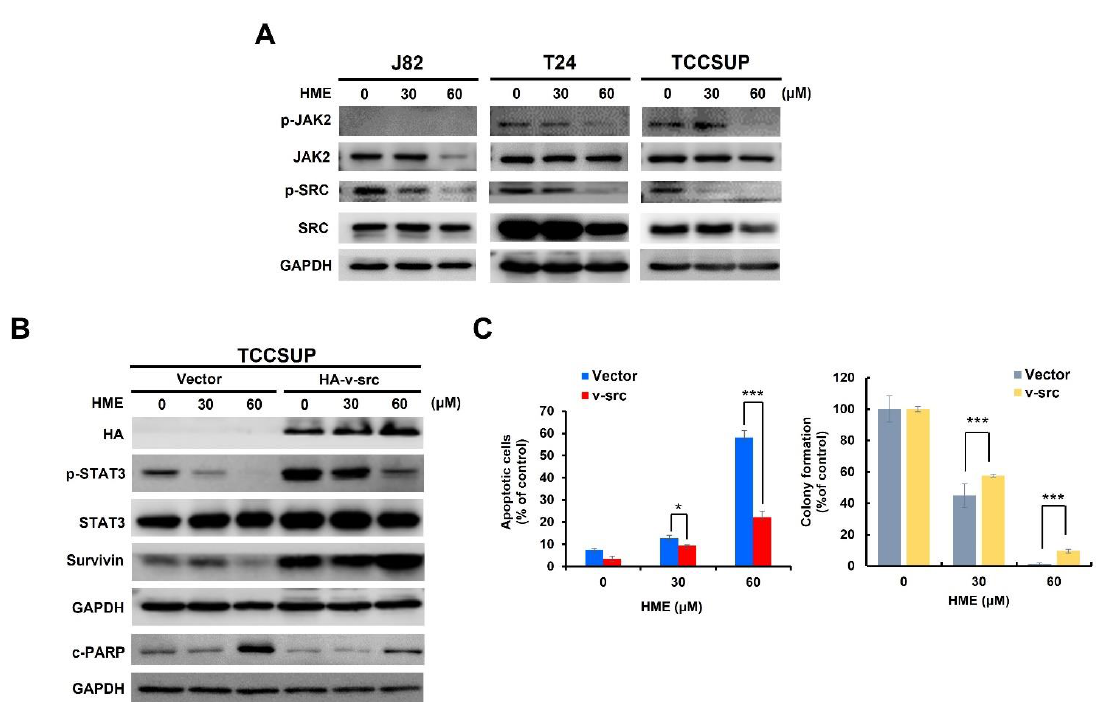
Figure 5. HME inhibits SRC to suppress the STAT3/survivin signaling axis. ( A ) HME inhibits SRC activation in all human bladder TCC cell lines examined. J82, T24, and TCCSUP cells were treated with HME (0, 30, 60 μM) for 24 h, followed by immunoblotting for the levels of tyrosine 1007/1008 - phosphorylated JAK2 (p-JAK2), total JAK2, tyrosine 416-phosphorylated SRC (p-SRC), total SRC, and GAPDH (loading control). ( B ) Ectopic expression of v-src, a dominant-active SRC, rescues both p-STAT3 and survivin levels from HME-mediated suppression but also attenuates HME-induced PARP cleavage. TCCSUP stable clones of HA-v-src and the respective vector control were treated with HME (0, 30, 60 µ M) for 24 h, followed by immunoblotting to evaluate the levels of HA, p-STAT3, total STAT3, survivin, c-PARP, and GAPDH (loading control). ( C ) v-src overexpression antagonizes the proapoptotic and cytotoxic effect of HME. TCCSUP stable clones of HA-v-src and the respective vector control were treated with HME (0, 30, 60 µ M) for 24 h, followed by annexin V/PI dual staining assay (left) and clonogenicity assay (right) to examine the HME-induced apoptosis and cytotoxicity, respectively. *: p < 0.05; ***: p <